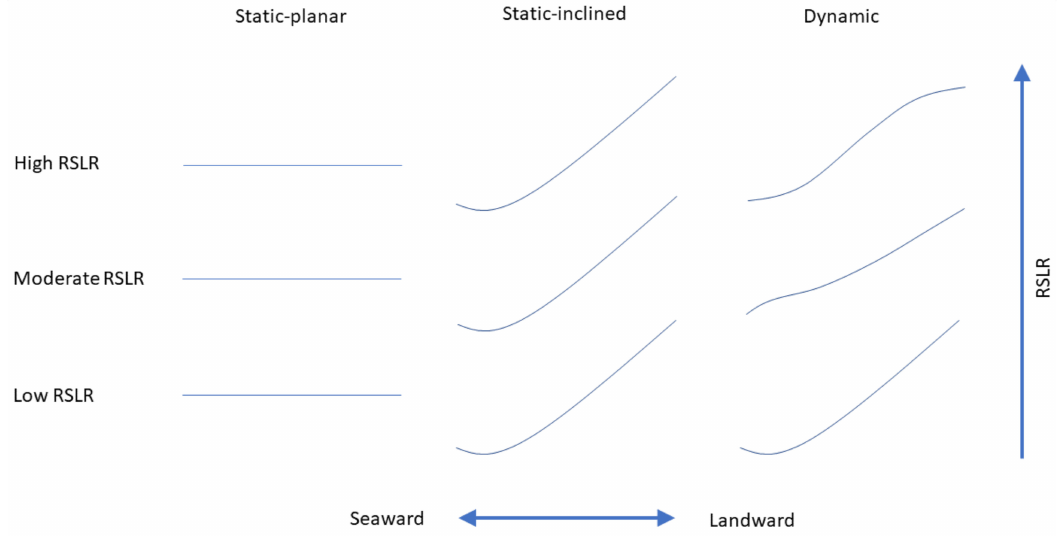
Figure 3. Schematic of water surface elevation changes applied within the three coastal-flood-modelling